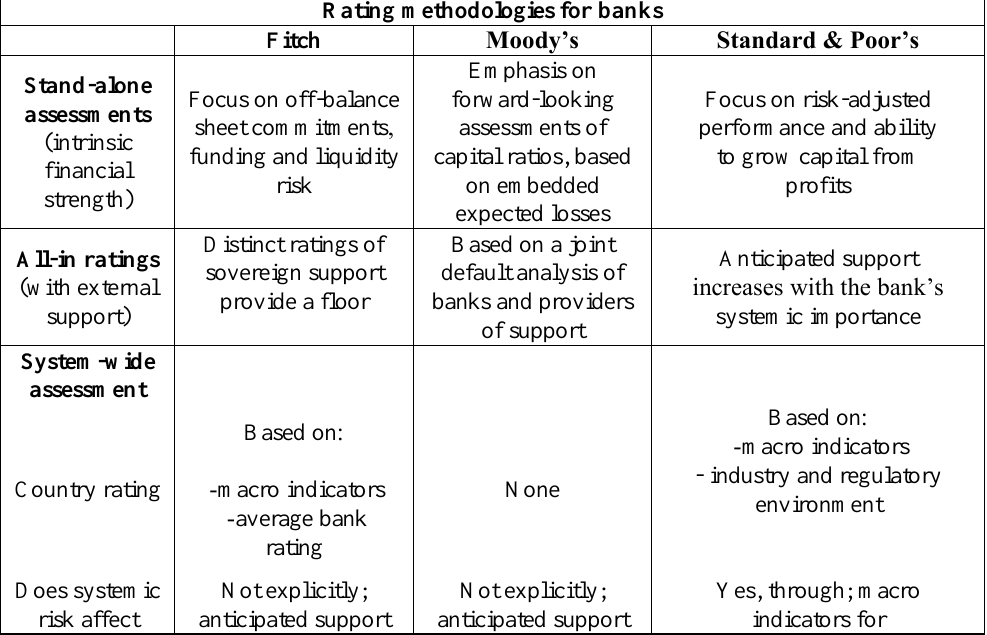
Table 1. Rating Methodologies for Bank Fitch, Moody's and Standard and